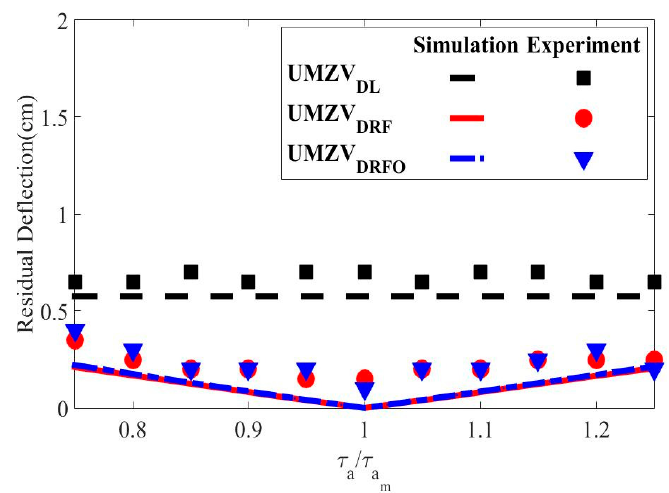
Figure 18. Experimental sensitivity to (cid:2028) (cid:3028) / (cid:2028) (cid:3028)